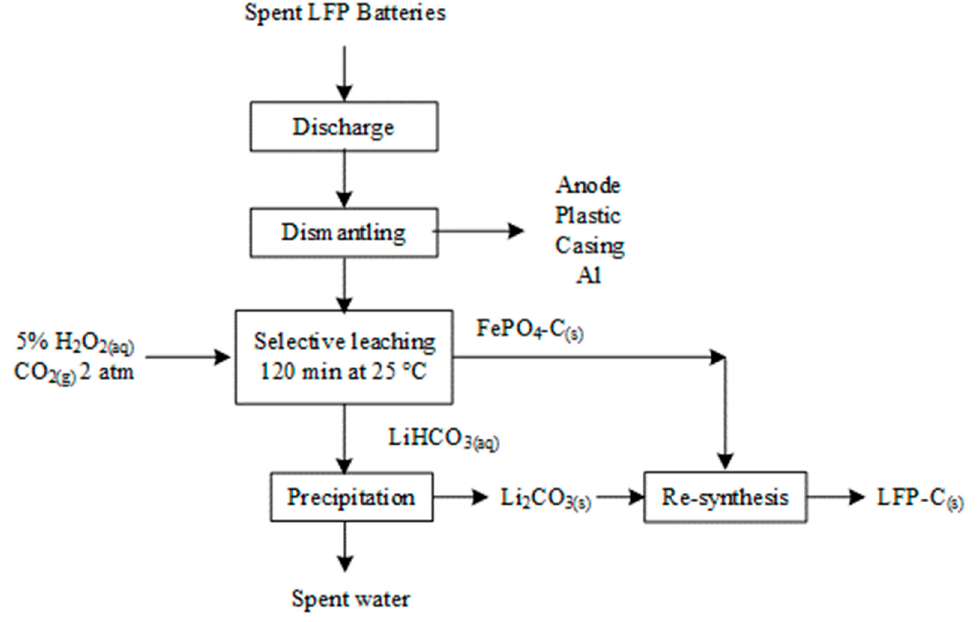
Figure 14. Selective leaching of LFP proposed by Amouzegar et al. (according to [185]); here, LFP is for LiFePO 4 .